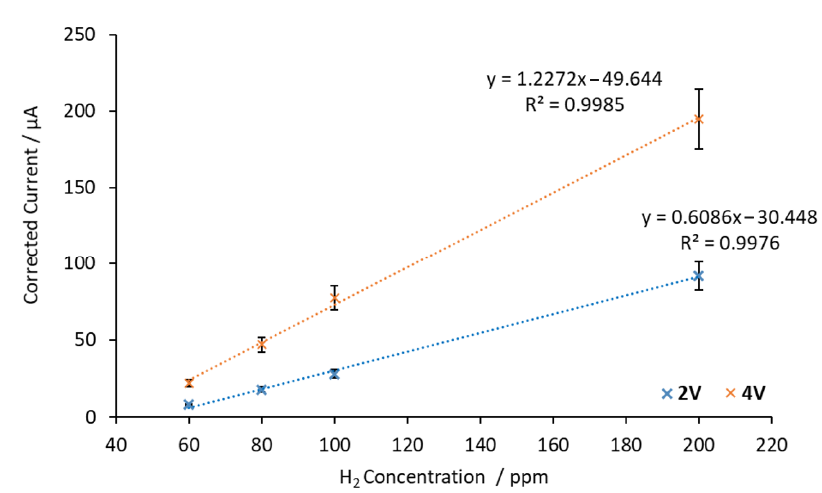
Figure 9. Calibration curves obtained with the BaCeZrY sensor by applying 2 V and 4 V between the electrodes at 500 °C.